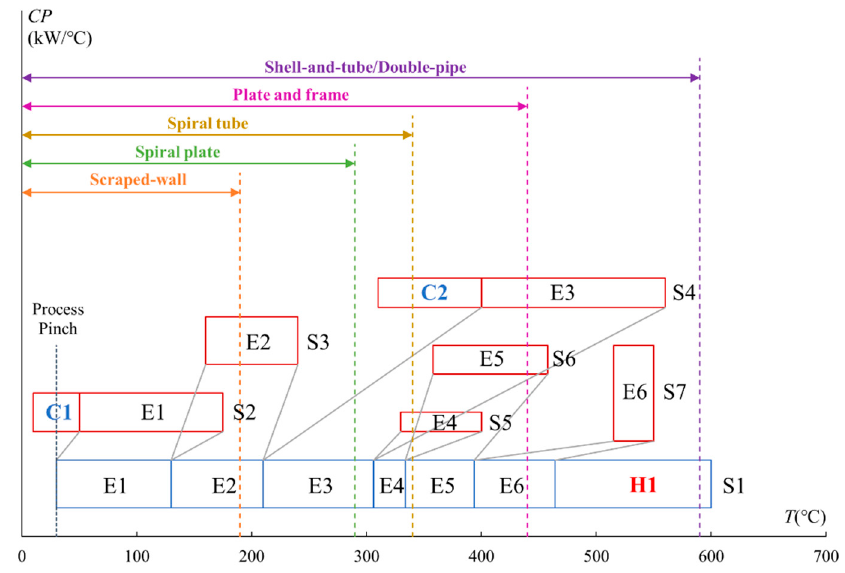
Figure 7. SRTGD-STR of the existing HEN for the case study.